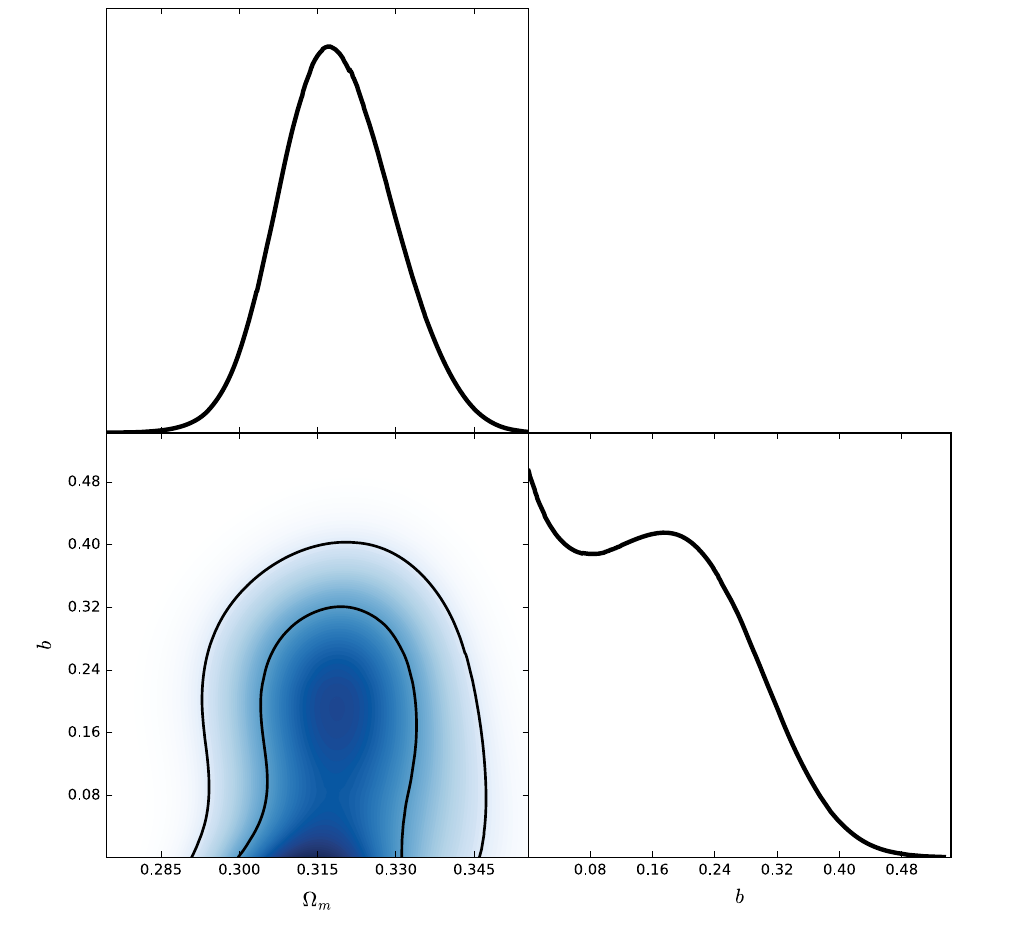
Fig. 6 The 68 and 95% confidence regions for the f 2 CDM model, which are constrained by the combined observational data of quasars, SN Ia, BAO and CMB